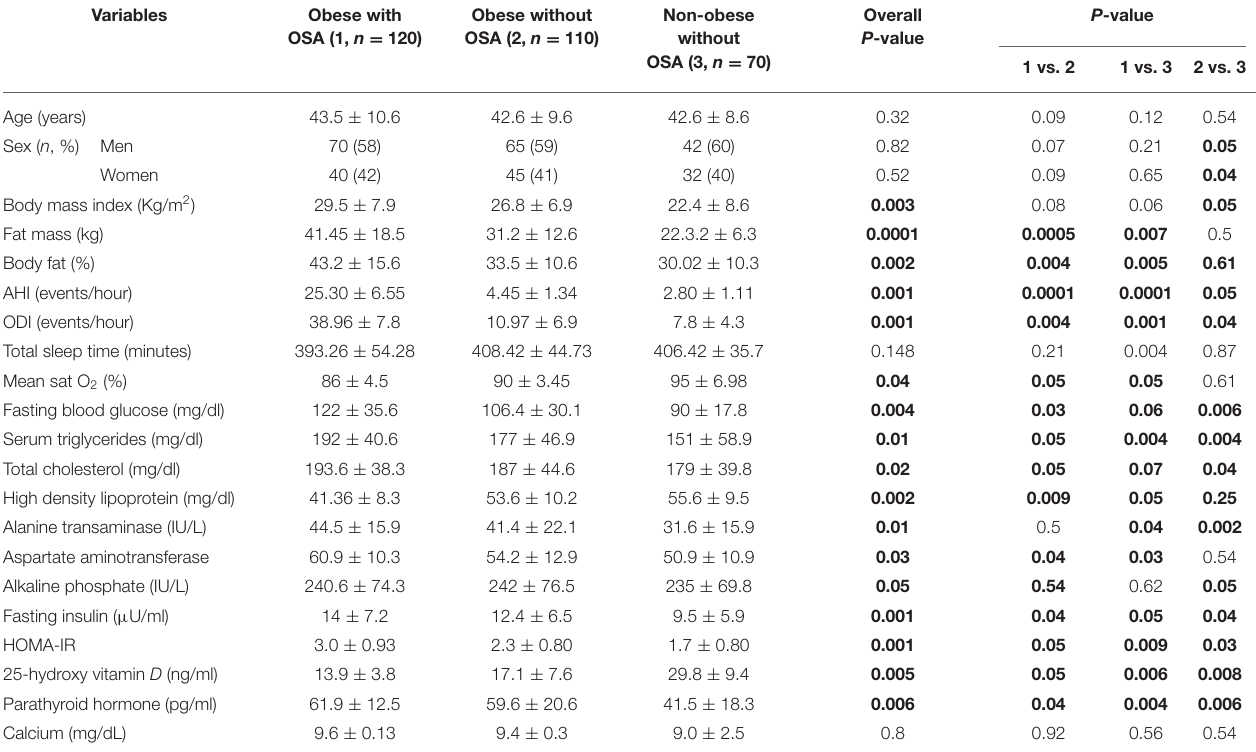
TABLE 1 | Demographic, anthropometry and biochemical profiles investigations. Variables Obese with